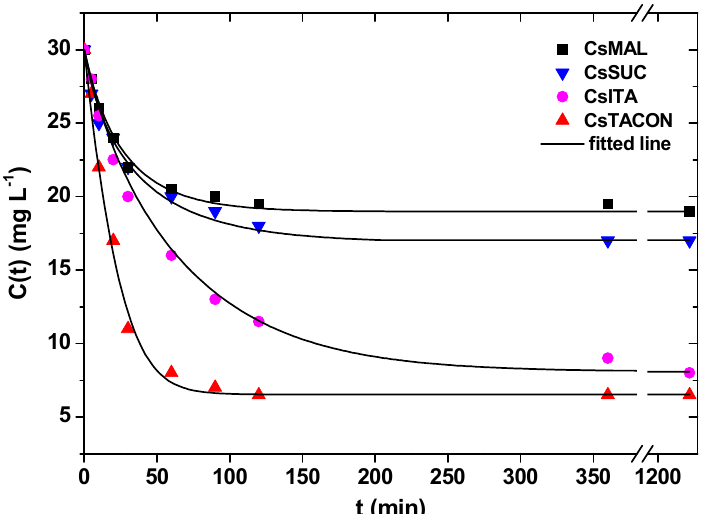
Figure 10. Comparison between experimental points (symbols) and model (lines) evolution curves for bulk solute concentration C(t).